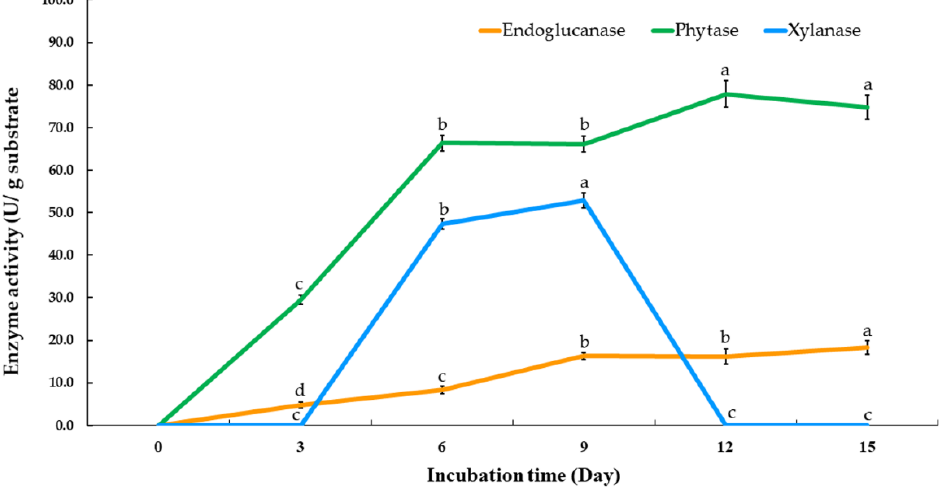
Figure 5. Time course of phytase, endoglucanase, and xylanase production by Thermoascus aurantiacus SL16W under semi-solid state fermentation. Different letters in the same column are considered significantly different according to Duncan’s multiple comparison test ( p ˂ 0.05).